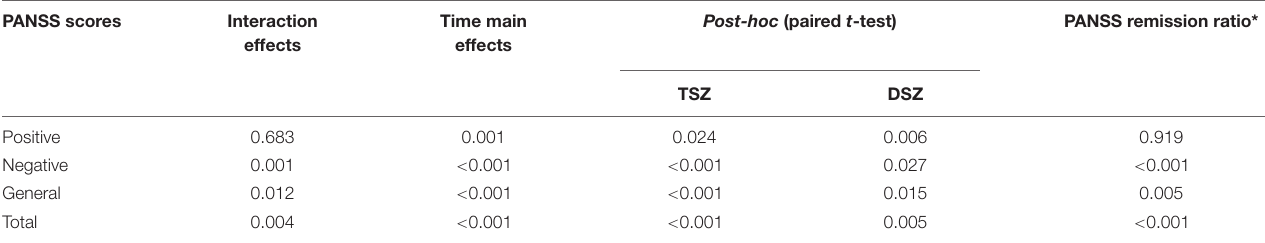
TABLE 2 | Repeated measured ANCOVA on Positive and Negative Syndrome Scale (PANSS) scores and the test of remission ratio between TSZ and DSZ